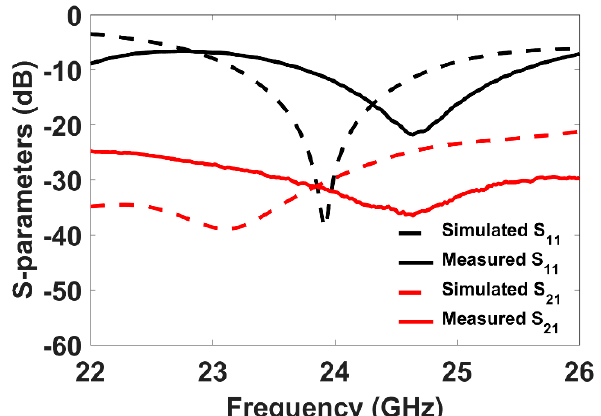
Figure 5. Simulated and measured S-parameters.